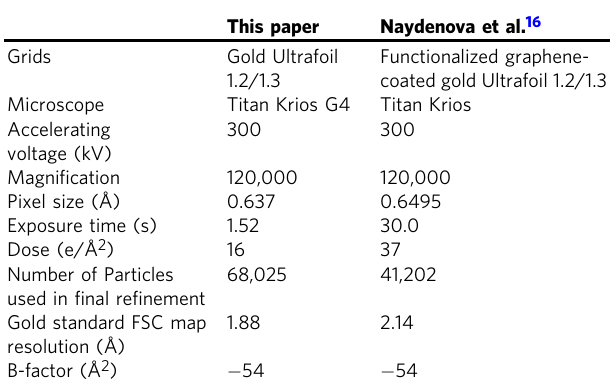
Table 1 Comparison of apoferritin data collection and reconstruction parameters between this paper and that in Naydenova et al. 1